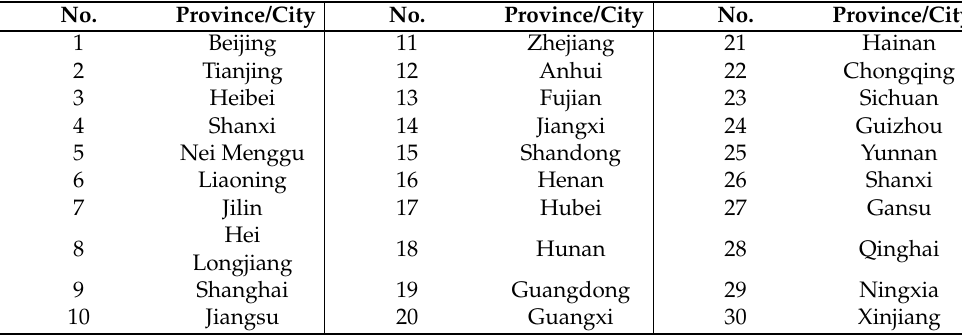
Table A1. Provinces corresponding to the numbers in the Moran scatter